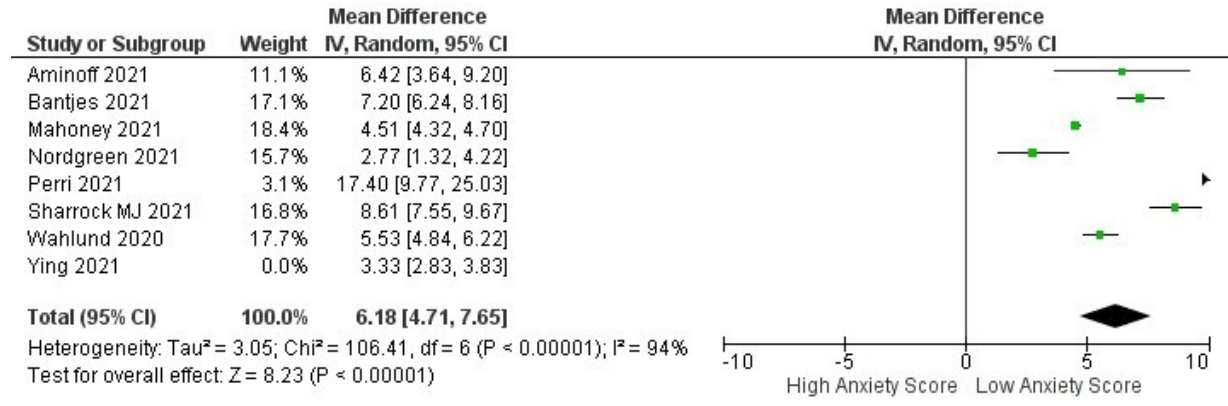
Figure 7. Sensitivity analysis for studies analyzing pre- and post- in anxiety